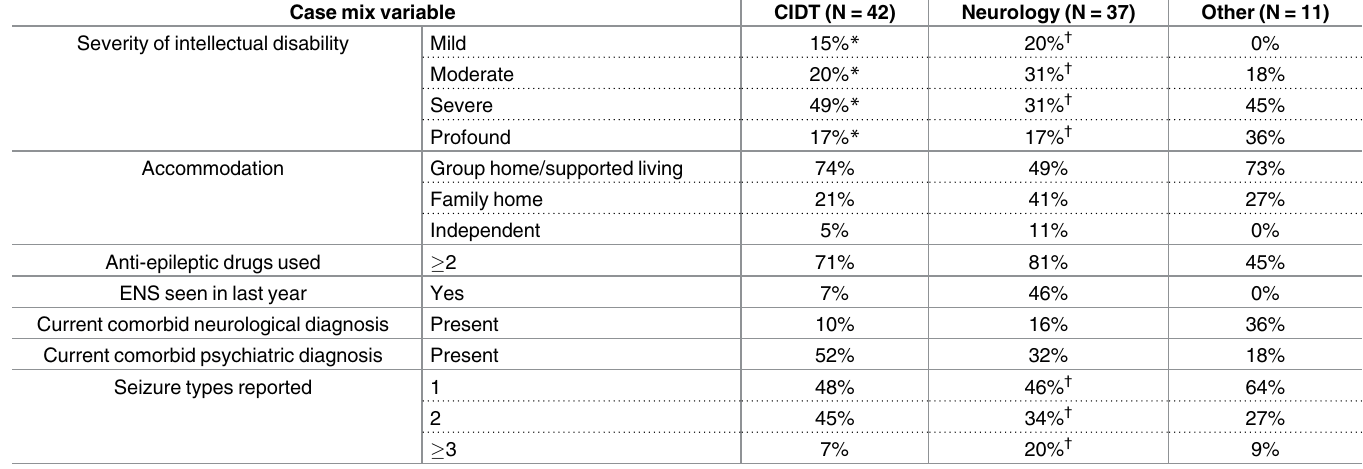
Table 1. The profile of patient heterogeneity (‘casemix’) variables within each of the clinical servicesand the Other group. CIDT = Community Intel- lectual DisabilityTeam. ENS = Epilepsy Nurse